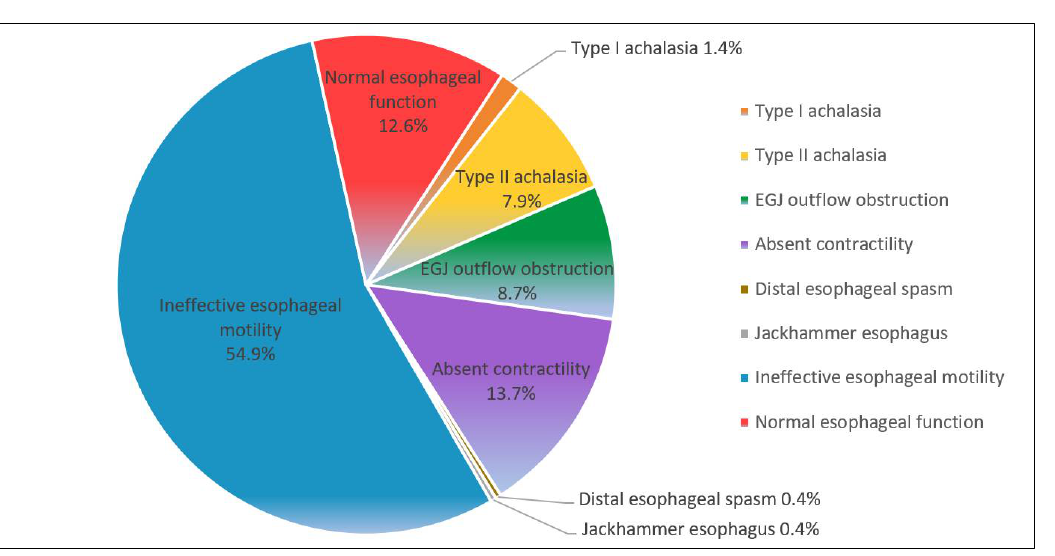
Figure 1. Prevalence of respective esophageal motility disorders based on Chicago Classification v3.0 scheme. Table 1. Demographics, clinical characteristics of the study subjects, and surgical intervention rates of patients with non-spastic motility